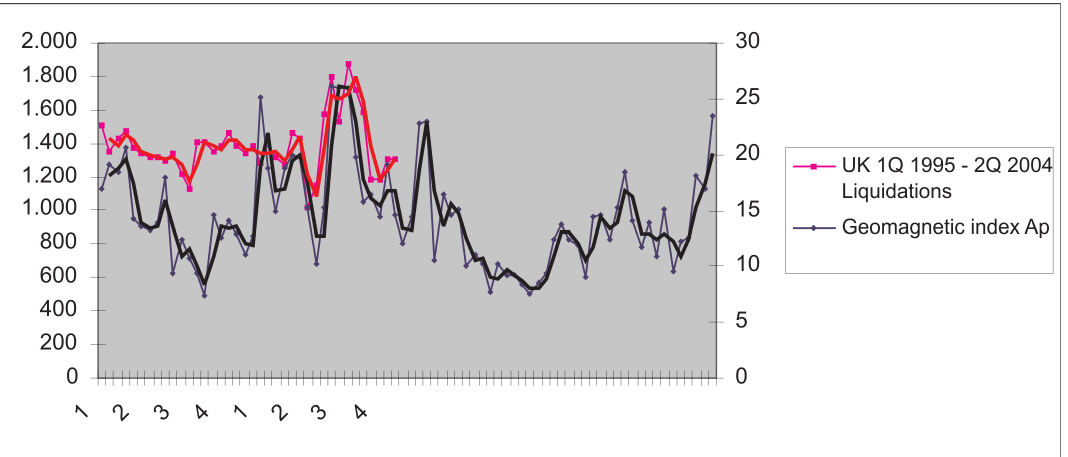
Figure 3. Quarterly time series: Number of liquidations of UK companies for period of 1Q 1995 - 2Q 2004 and geomagnetic activity index Ap [t-x2] – with time lag x2 and their moving averages